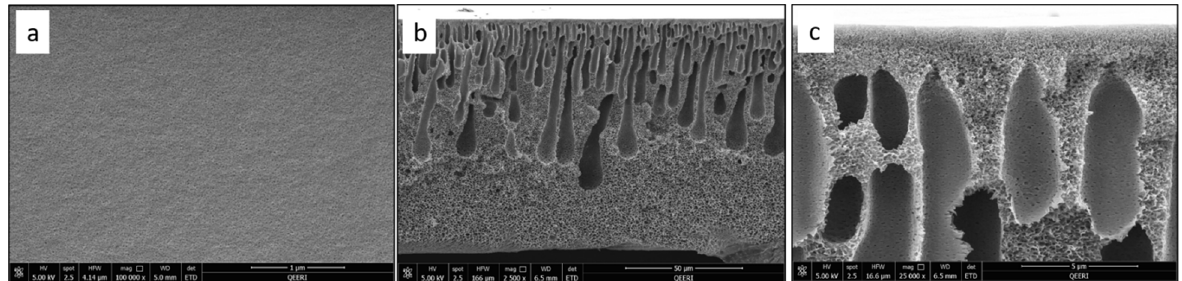
Figure 4. SEM images for pure PSF (M1) sample: ( a ) top surface, ( b ) cross-section, ( c ) enlarged top cross-section.